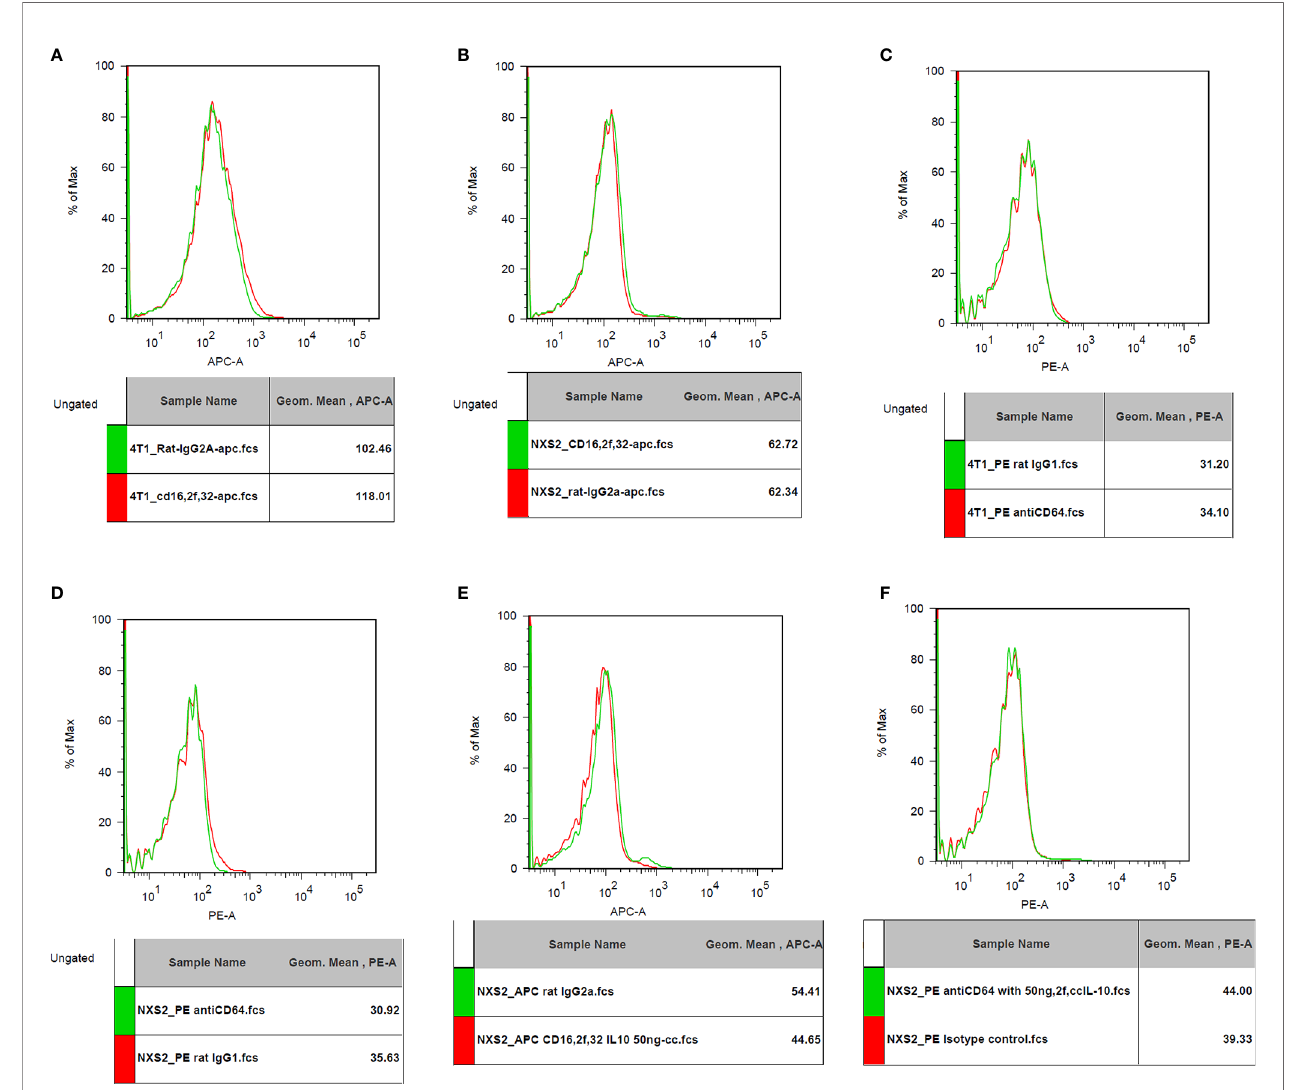
FIGURE 6 | CD16/32 expression on 4T1 or NXS2 cells. (A) . CD16/32 Fc receptor expression on 4T1 cells compared to isotype control. There was no CD16/32 expression on 4T1 cells. (B) CD16/32 Fc receptor expression on NXS2 cells compared to isotype control. There was no CD16/32 expression on NXS2 cells. (C) CD64 Fc receptor expression on 4T1 cells compared to isotype control. There was no CD64 expression on 4T1 cells. (D) CD64 Fc receptor expression on NXS2 cells compared to isotype control. There was no CD64 expression on NXS2 cells. (E) CD16/32 Fc receptor expression on NXS2 cell treated by IL-10 50ng/cc for two days. There was no expression of CD16/32. (F) CD64 Fc receptor expression on NXS2 cell treated by IL-10 50ng/cc for two days. There was no expression of